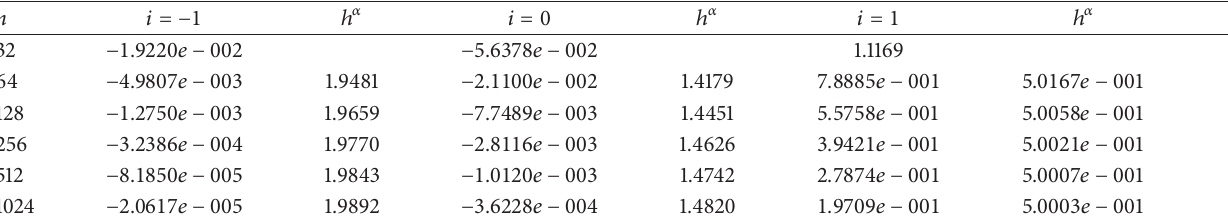
Table 5: Errors of the mod-trapezoidal rule.